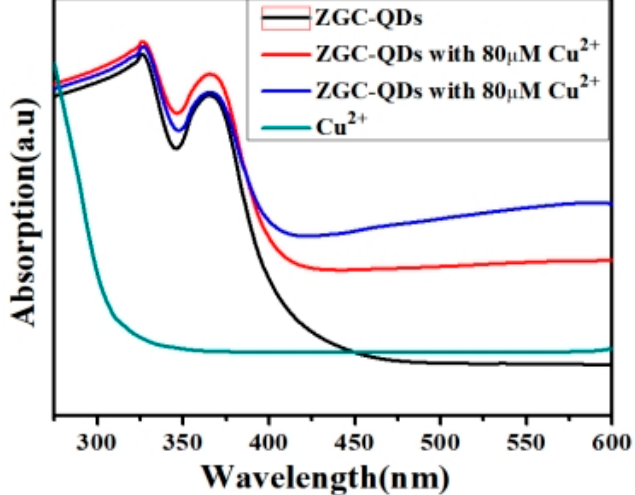
Figure 7. UV–vis absorption spectra of mixed colloids.